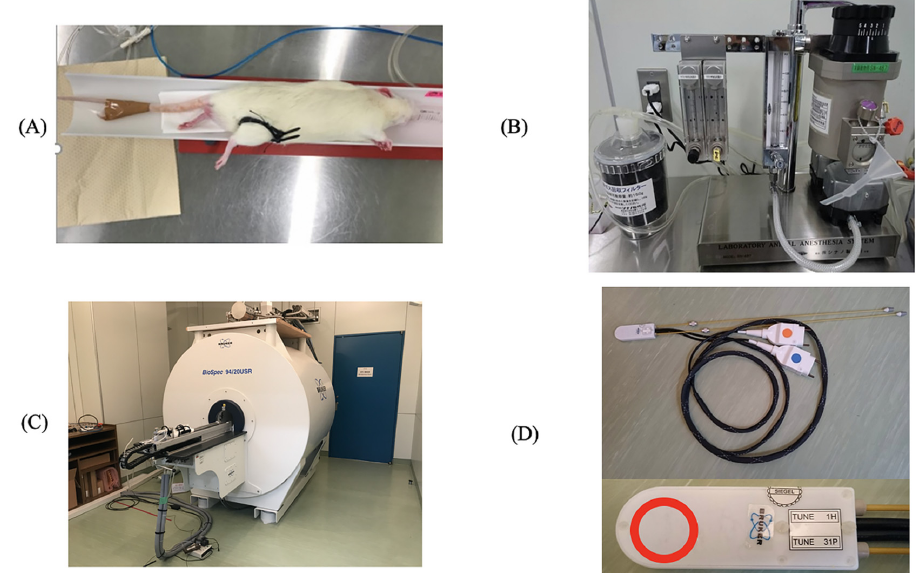
Figure 2. The experiment’s equipment. The prepared rat was placed in a left lateral position ( A ) on a dedicated MR cradle and connected to an anesthesia system ( B ), where the inhalation concentration could be adjusted accordingly. An ultra-high field 9.4 Tesla magnetic resonance imaging (MRI) machine ( C ) and a surface coil capable of observing the biochemical kinetics of 1 H and 31 P ( D ) were fixed to the right lower leg region. The red circle (20 mm inner diameter) is the region of interest.